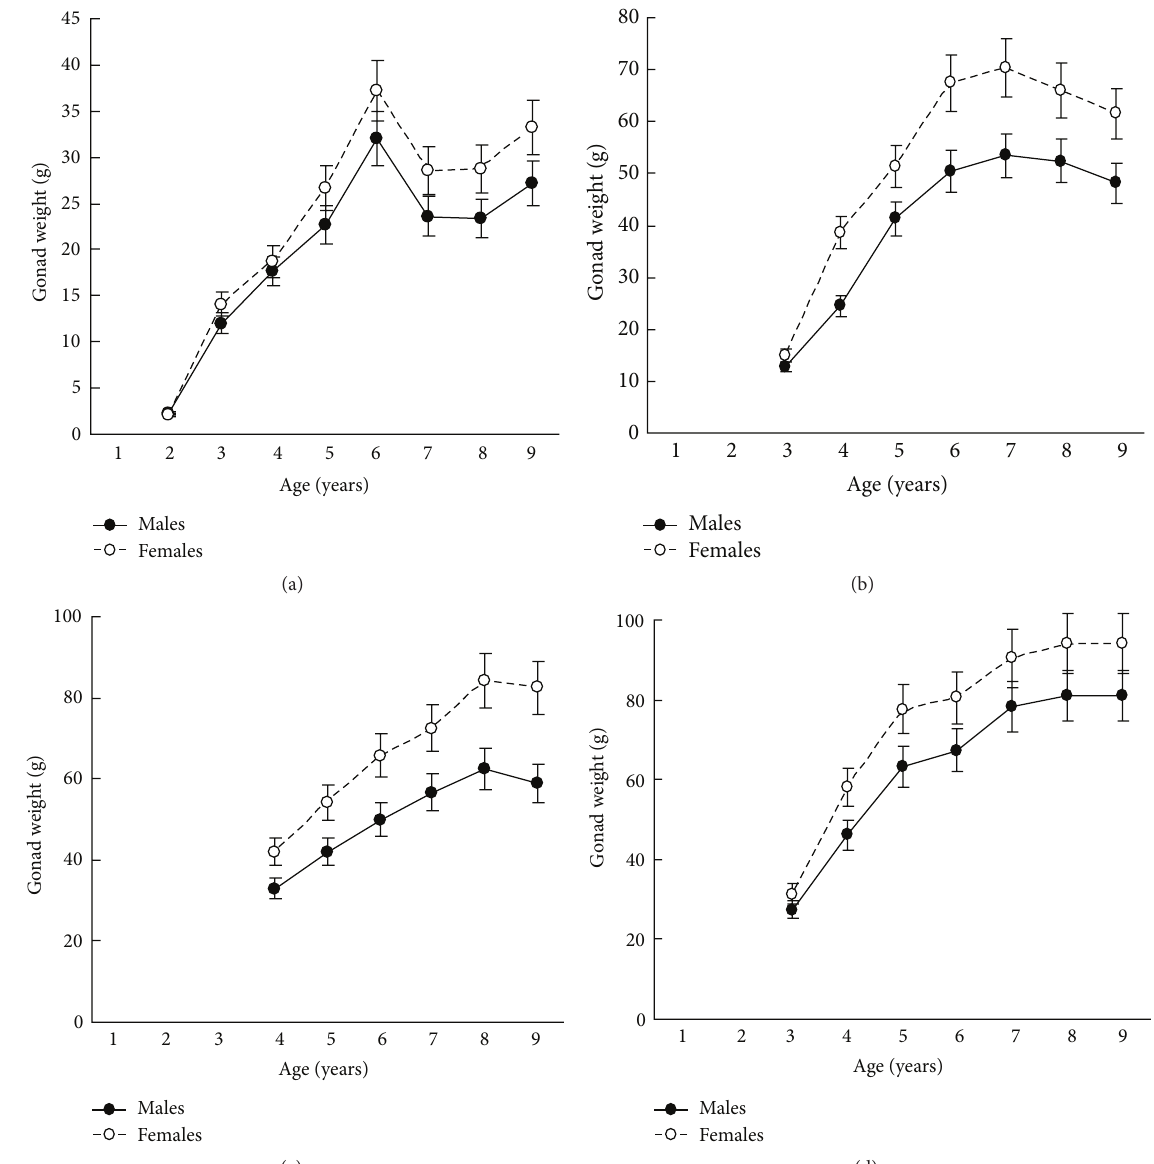
Figure 4: Patinopecten yessoensis .Gonad weight growth of themales and females in thestudied sites:(a) Ozero Vtoroe Bay; (b)Melkovodnaya Bay; (c) Vityaz Bay; (d) Zapadnaya Bay of Furugalm Island. Data are mean ±